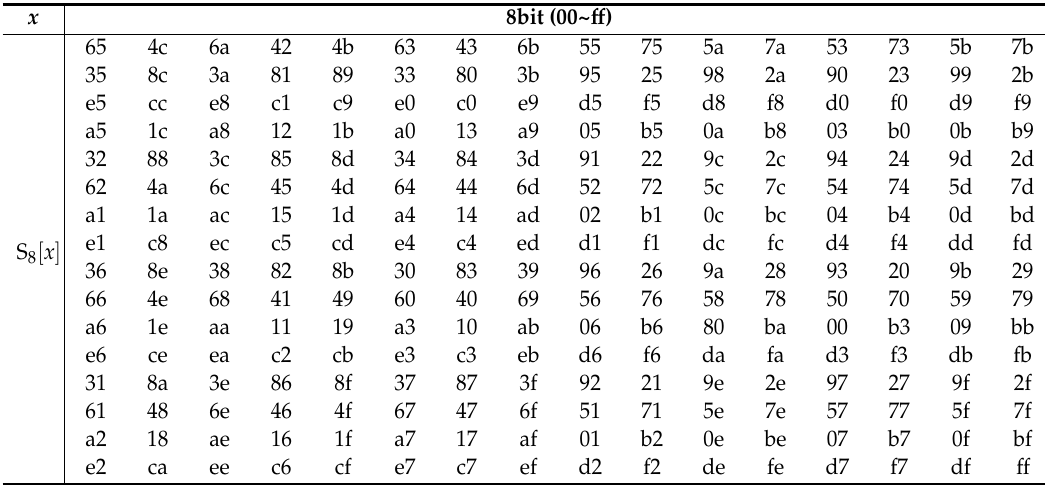
Table 3. 8-bit Sbox S 8 used in